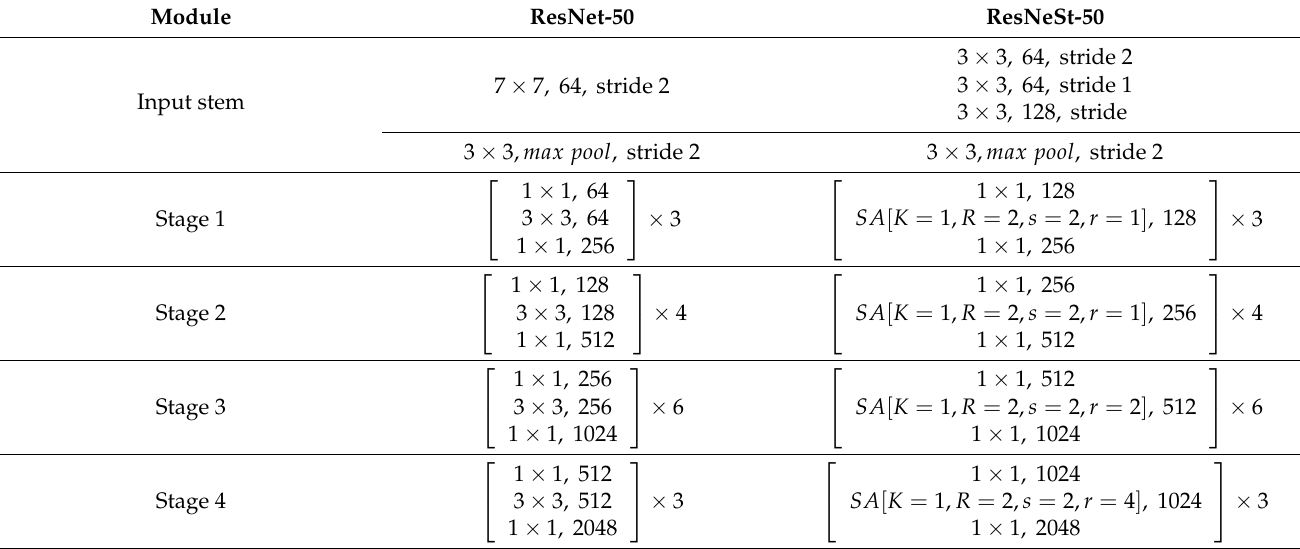
Table 1. Network structure of ResNet-50 and ResNeSt-50. The second column refers to the ResNet-50, and the third column refers to the ResNeSt-50. The input stem of split-attention networks (ResNeSt)-50 uses three consecutive 3 × 3 convolutions to replace a 7 × 7 convolution. The residual/split-attention blocks are in square brackets; the number of blocks stacked in each stage is displayed outside the